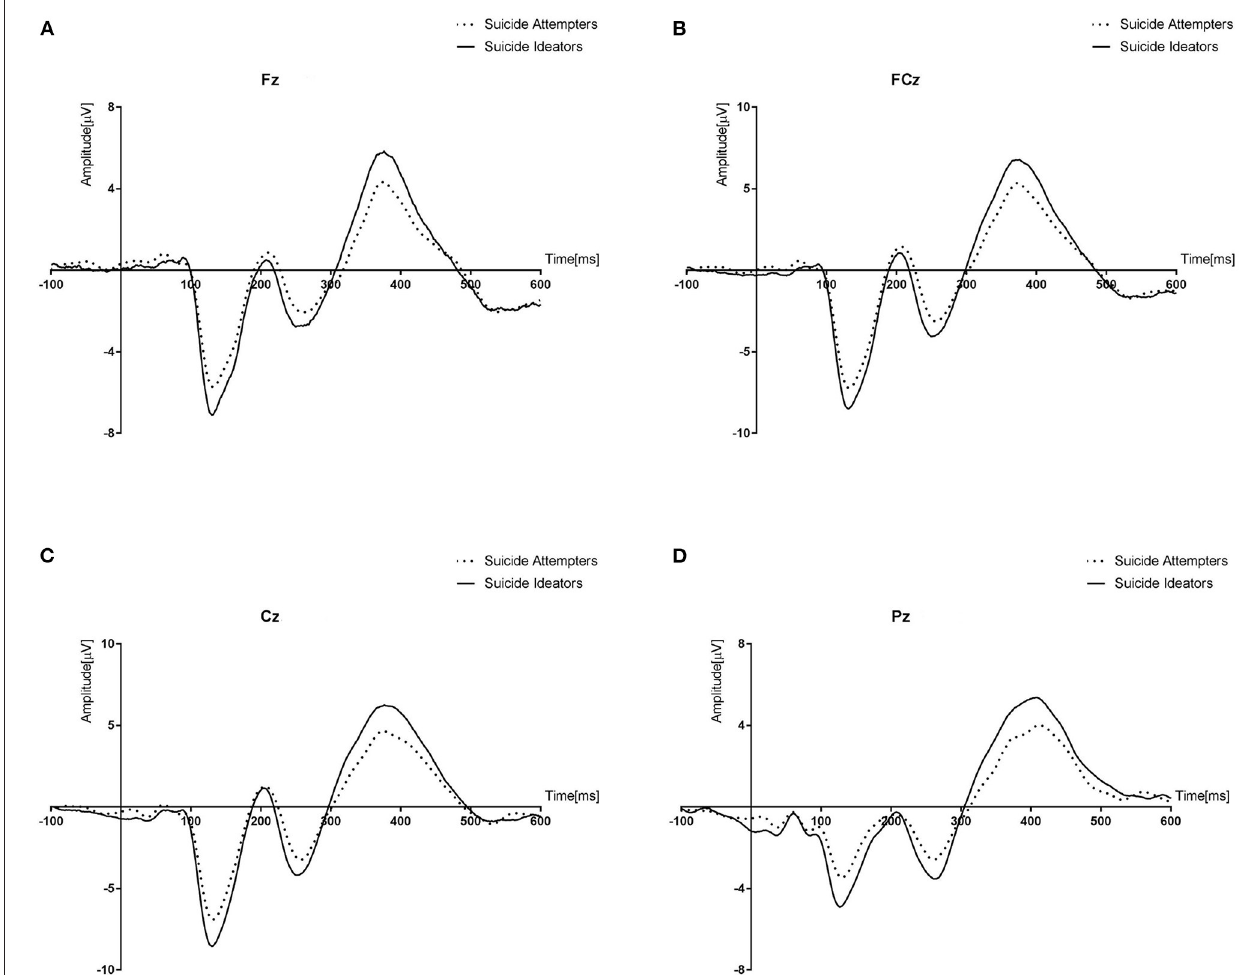
FIGURE 1 | Grand averages of no-go Event Related potentials (ERPs) at all electrodes (Fz, FCz, Cz, and Pz) between suicide ideators and suicide attempters. Suicide ideators had more positive no-go P3 amplitude than those of suicide attempters at all electrodes. (A) no-go P3 amplitude at Fz. (B) no-go P3 amplitude at FCz. (C) no-go P3 amplitude at Cz. (D) no-go P3 amplitdue at